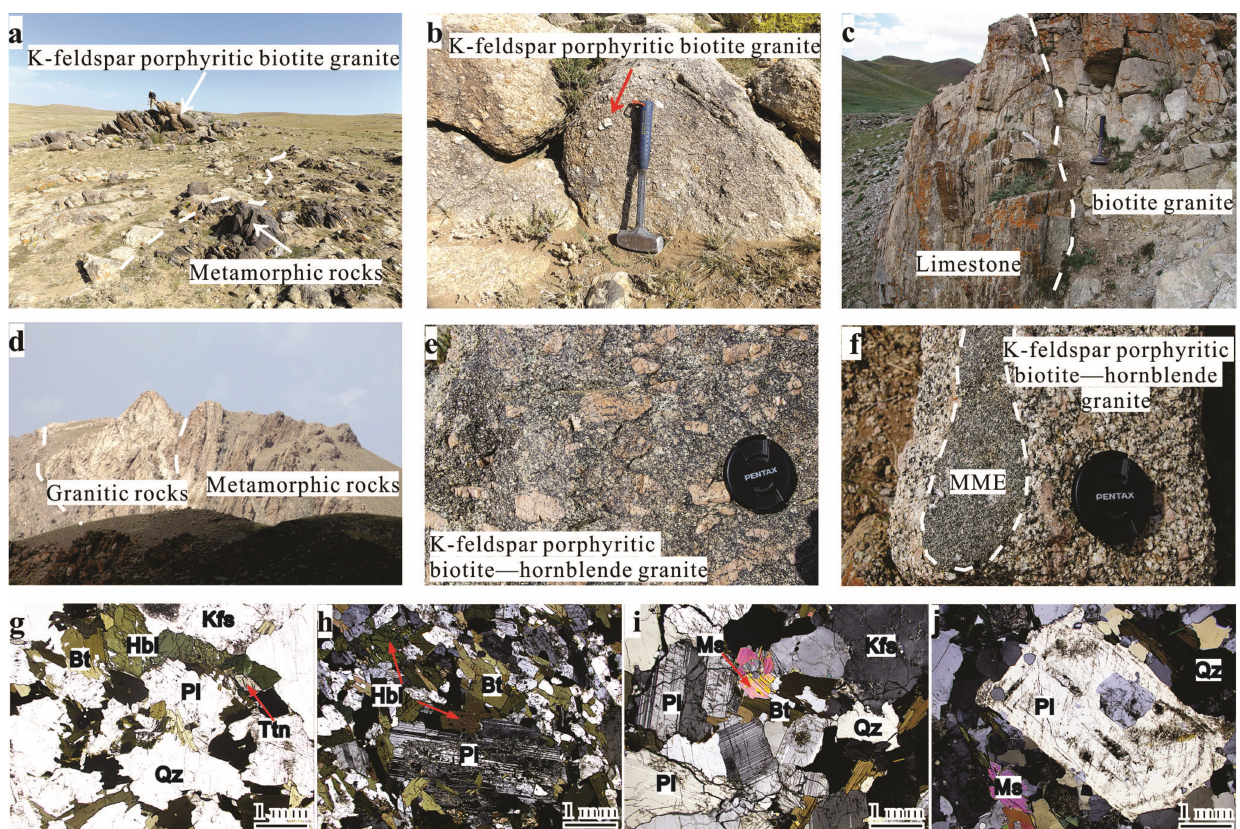
Fig. 2. Field setting and photomicrographs of representative analyzed samples in the Baidrag area. (a) K- feldspar porphyritic biotite granite and metamorphic rocks (samples 15082105A, B), (b) K-feldspar porphyritic biotite granite (sample 15082105A), (c) Biotite granite in contact with limestone (sample 15082205A), (d) Granitic rock emplaced into metamorphic country rock, (e) Red-colored K-feldspar porphyritic biotite–hornblende granite (sample 15082102), (f) Red-colored K-feldspar porphyritic biotite–hornblende granite containing a MME (sample 15082106), (g) K-feldspar porphyritic biotite–hornblende granite (sample 15082102), (h) MME (sample 15082106C) within the K-feldspar porphyritic biotite–hornblende granite, (i) K-feldspar porphyritic biotite granite (15082105A), (j) Biotite–muscovite granite